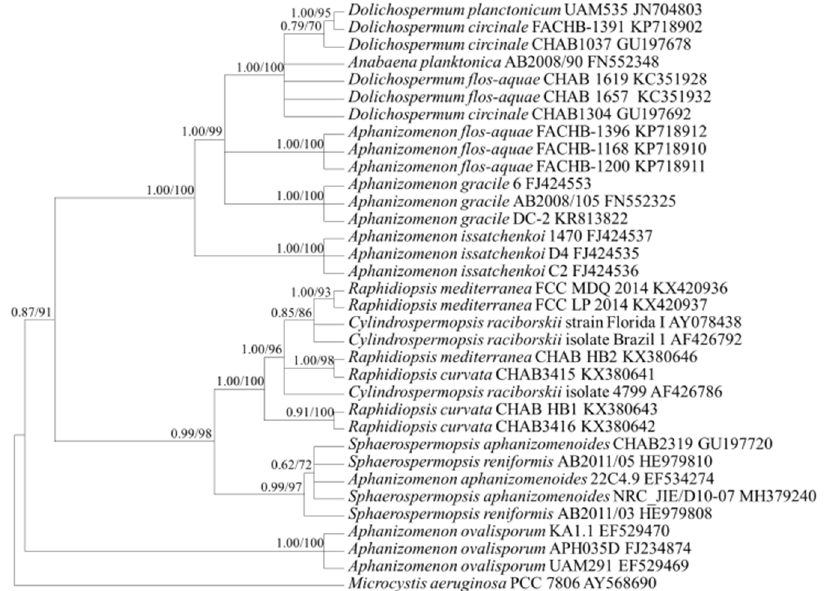
Figure 2. Consensus Bayesian tree based on aligned 322-bp sequences of cpcBA using the GTR+G+I model with Microcystis aeruginosa as an outgroup. The parameters were as follows: assumed equal nucleotide frequency; substitution rate matrix with A–C substitutions = 0.1590, A–G = 0.2297, A–T = 0.1304, C–G = 0.0518, C–T = 0.3314, and G–T = 0.0974; proportion of sites assumed to be invariable = 0.1173; and rates for variable sites assumed to follow a gamma distribution with the shape parameter = 6.8674. The branch lengths are proportional to the amount of character changes. The numbers above the branches indicate the Bayesian posterior probability ( left ) and maximum-likelihood bootstrap values ( right ). Posterior probabilities ≥ 0.5 are shown.